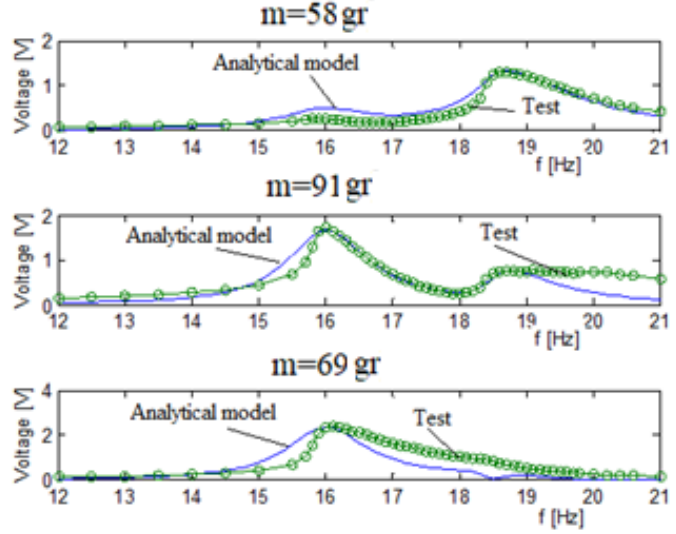
Figure 10. Three bimorphs system output voltage (parallel electrical connection)—experimental results vs. analytical predictions.